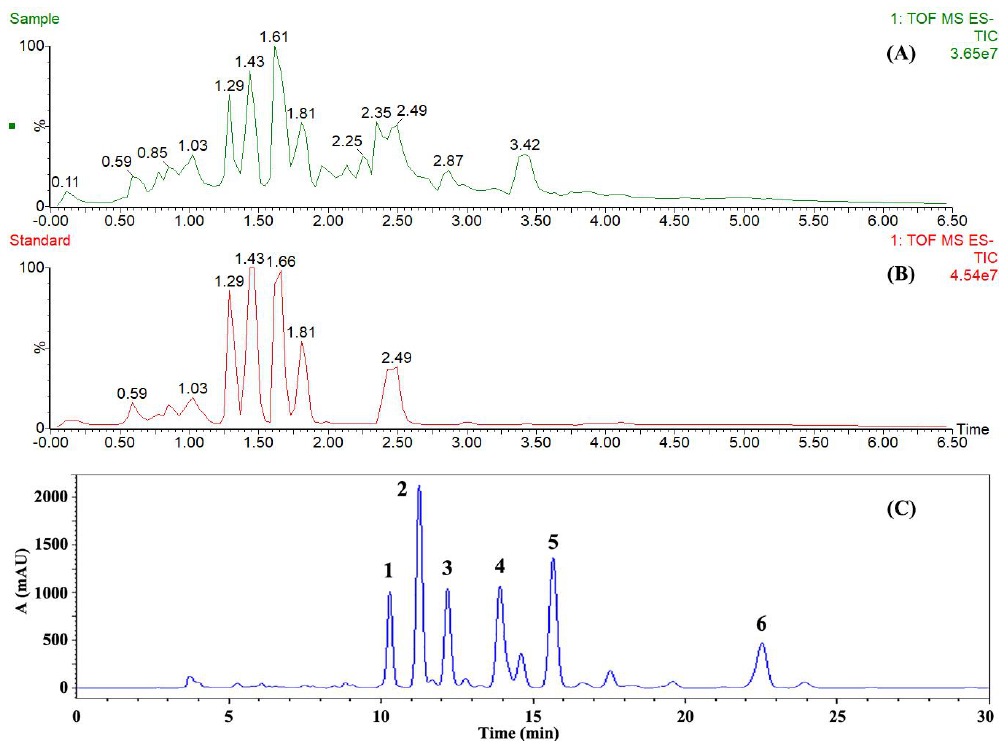
Figure 3. The mass spectrometry and HPLC chromatogram of Rana chensinensis ovum oil (RCOO). ( A ) The total ion current (TIC) chromatogram of RCOO sample. ( B ) The total ion current (TIC) chromatogram of unsaturated fatty acid (UFA) standards. ( C ) The HPLC chromatogram of RCOO sample.